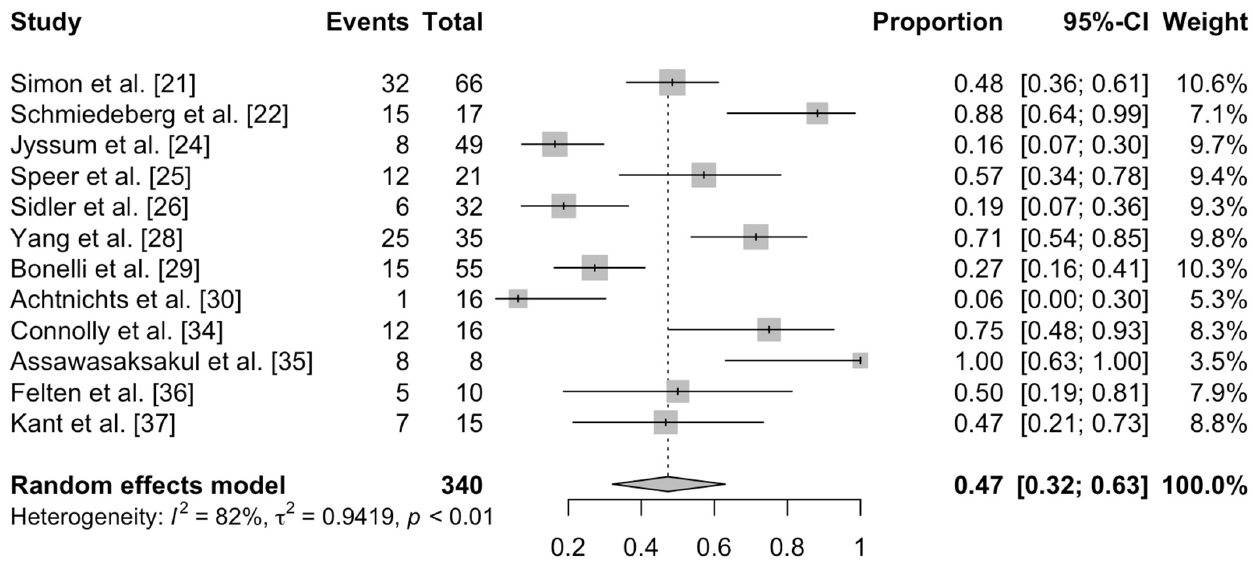
Figure 2. Rate of seroconversion after administration of a booster dose in non-responders to a pri- mary series of COVID-19 vaccination. series of COVID-19 vaccination. Table 2. Subgroup analysis according to key categorical